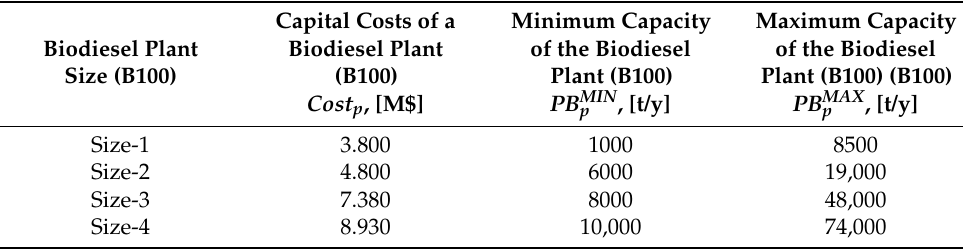
Table 4. Total specific investment costs for biodiesel (B100) plants as a function of the plants’ capacities [40,41].